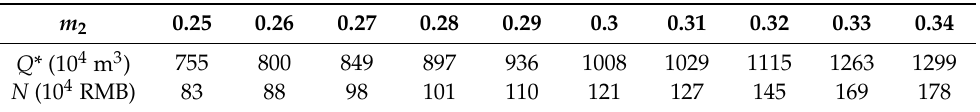
Table 3. The results of experiment scheme 1.